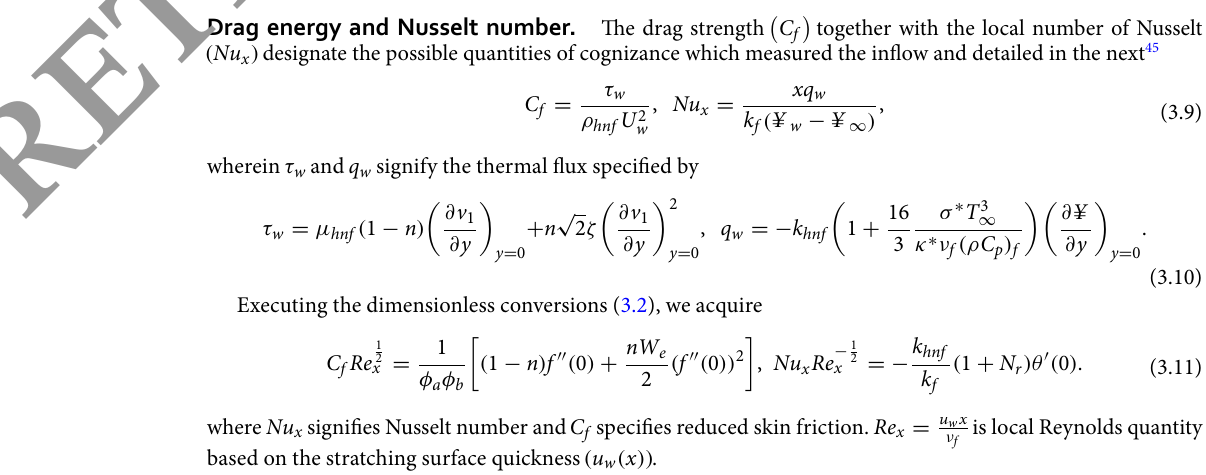
Depiction of the entrenched regulating physical constraints. Equation (2.2) is accurately con- firmed. In earlier equations, the symbolization ′ used for signifying the derivatives regarding Ŵ . Here σ f B 2 2 c 3 ζ x n (power law index) and M W e ν f (Weissenberg number), c ρ f (magnetic) constraints defined = = ν f α f (cid:31) respectively along with the P r = α f (Prandtl number), = ν f h g ber)and B i k g b (Biot number) parameters respectively. = (cid:31) Drag energy and Nusselt number. The drag strength C f together with the local number of Nusselt ( Nu x ) designate the possible quantities of cognizance which measured the inflow and detailed in the next 45 (cid:31) (cid:30)